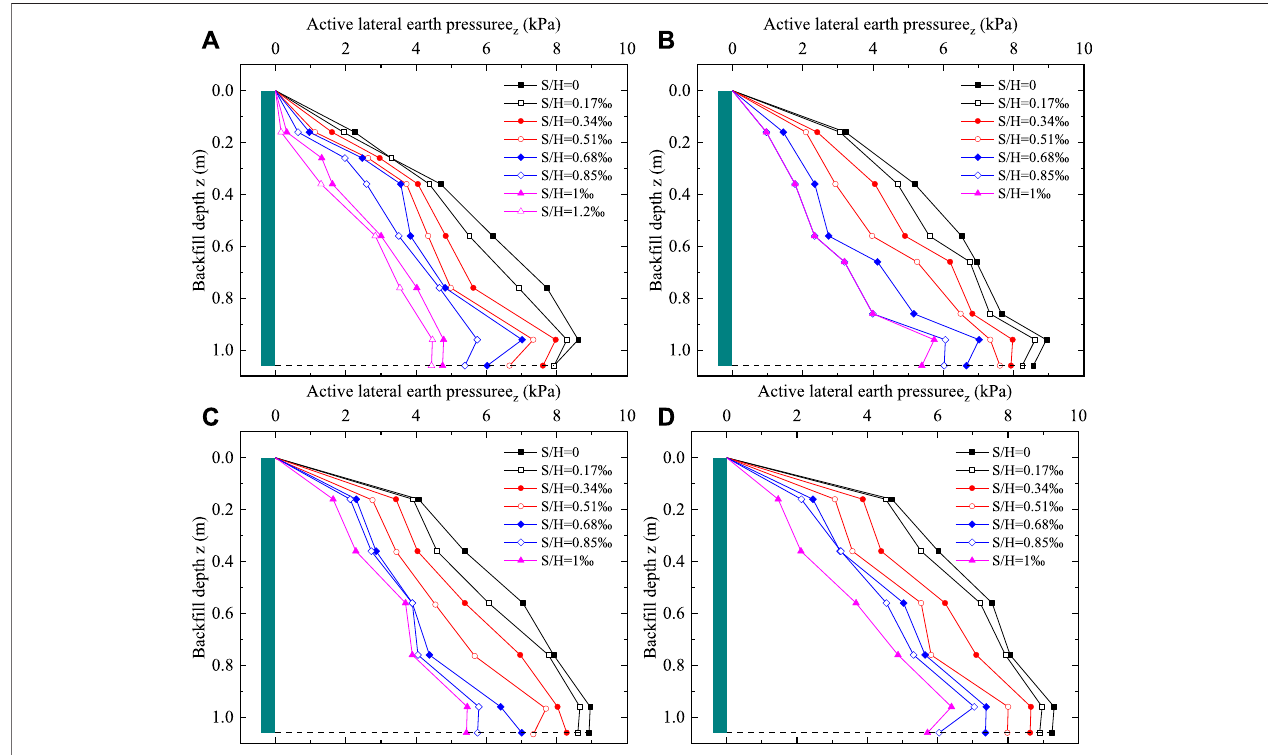
FIGURE 5 | Active lateral earth pressure distribution during wall translation at different slope angles. (A) β = 40 ° . (B) β = 50 ° . (C) β = 60 ° . (D) β = 70 ° .